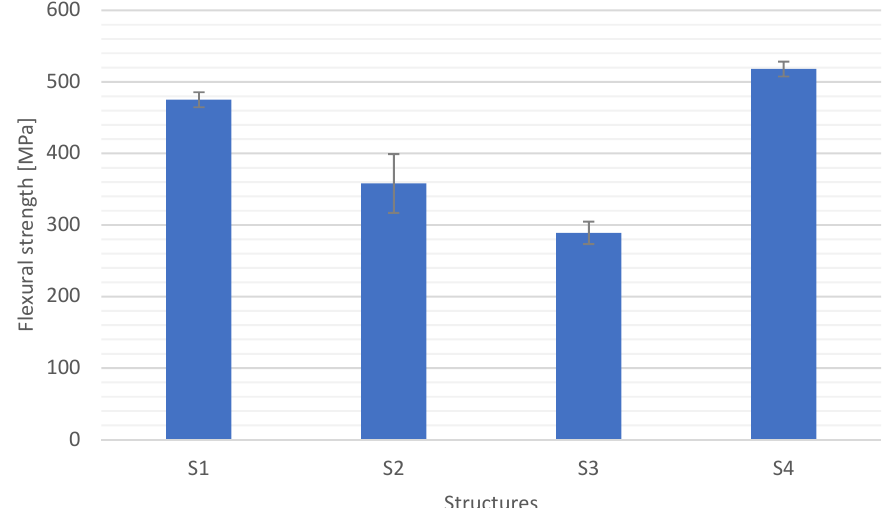
Figure 12. Flexural strength for different composite structures.